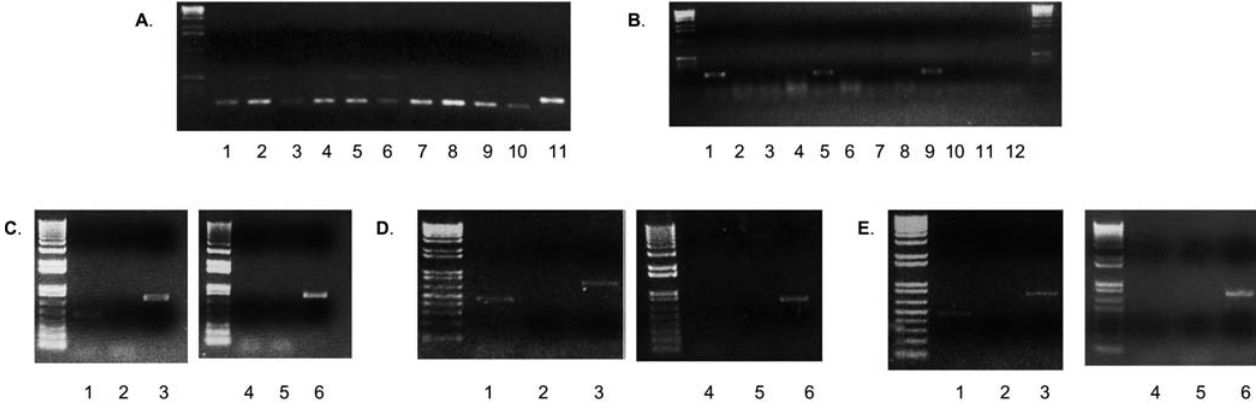
Figure 3. Expression Study Results for the Ba¨llchen and Hun gene (A) Ba ¨ llchen is expressed ubiquitously in both D.melanogaster and D. simulans: whole body, D. melanogaster (1), D. simulans (2); head, D. melanogaster (3), D. simulans (4); thorax, D. melanogaster (5), D. simulans (6); testes, D. melanogaster (7), D. simulans (8); and accessory gland with ejaculatory duct, D. melanogaster (9), D. simulans (10). Lane 11 is a genomic control. (B) RT-PCR results for Hun from adult male and female D. simulans, D. mauritiana, and D. sechellia flies. Hun ’s expression is limited to D. simulans, D. mauritiana, and D. sechellia males, lanes 1, 5, and 9, respectively. Lanes 3, 7, and 11 are (D) D. simulans, D. mauritiana, and D. sechellia females. Lanes 2, 4, 6, 8, 10, and 12 are corresponding RT-controls. (C–E) Tissue specific RT-PCR results for the Hun gene in D. simulans (C), D. mauritiana (D), and D. sechellia (E). For these RT-PCR experiments testes were dissected from the rest of body. Hun ’s expression is testes-specific for each species: testes, lane 1; RT- control, lane 2; Gapdh-2 positive control, lane 3; rest of body, lane 4; RT-control, lane 5; Gapdh-2 positive control, lane 6. DOI: